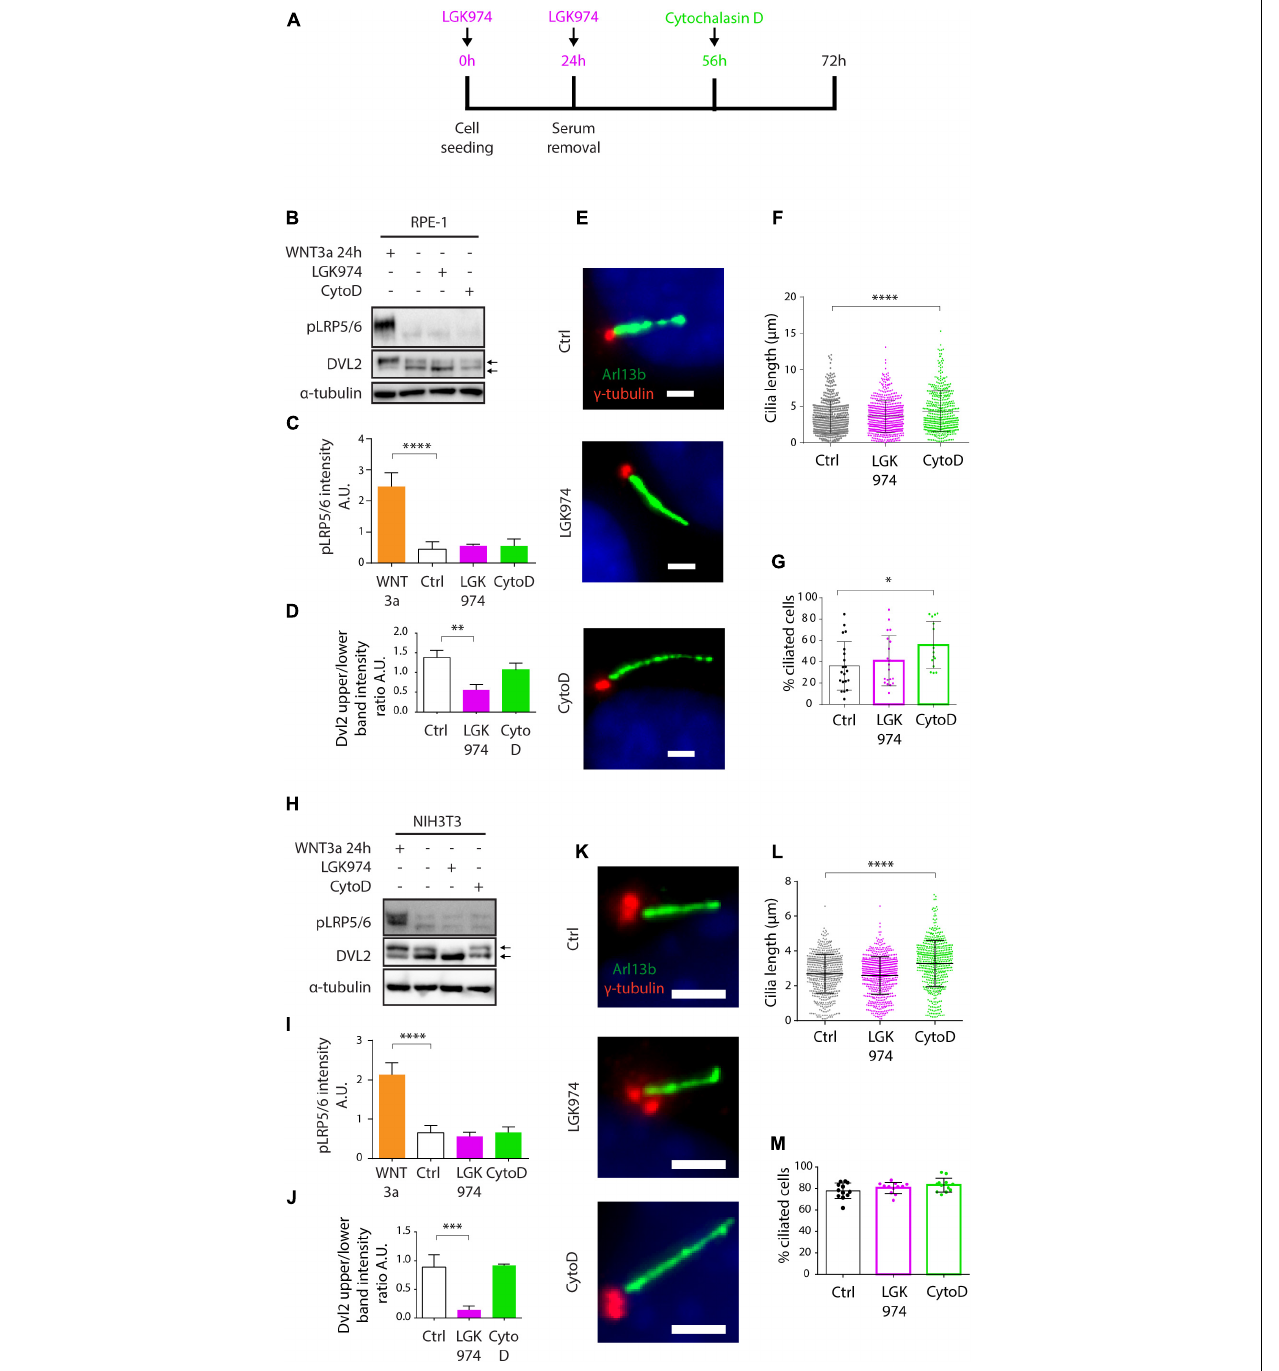
FIGURE 2 | Inhibition of WNT secretion has no effect on ciliogenesis or cilia length. (A) Experimental scheme illustrating the time points of LGK974 (Purple) or CytoD (Green) treatments. (B) Western blot analysis of RPE-1 treated by LGK974 or CytoD. WNT3a was used as positive control to activate WNT/ β -catenin pathway. pLRP5/6 intensity is quantified in (C) n = 3, DVL2 shift (upper to lower band intensity ratio) is quantified in (D) n = 3. (E) Representative images of RPE-1 cells following the indicated treatment, stained for Arl13b (green) and γ -tubulin (red). Scale bar = 2 µ m. DAPI (blue) was used to counter stain nuclei. Quantification of the cilia length (F) and the percentage of cells with Arl13+ cilium (G) . Each dot indicates either length of a single primary cilium (F) or percentage of ciliated cells in one image frame (G) n ≥ 3. (H) Western blot analysis NIH3T3 treated by LGK974 or CytoD. pLRP5/6 intensity is quantified in (I) n = 3, (J) Quantification of DVL2 band intensities (upper to lower band intensity ratio) n = 3. (K) Representative images of NIH3T3 cells following treatment with LGK974 or CytoD, stained for Arl13b (green) and γ -tubulin (red). Scale bar = 2 µ m. DAPI (blue) was used to counter stain nuclei. Quantification of the cilia length (L) and the percentage of cells with Arl13+ cilium (M) . Each dot indicates either length of a single primary cilium (L) or percentage of ciliated cells in one image frame (M) n = 3.